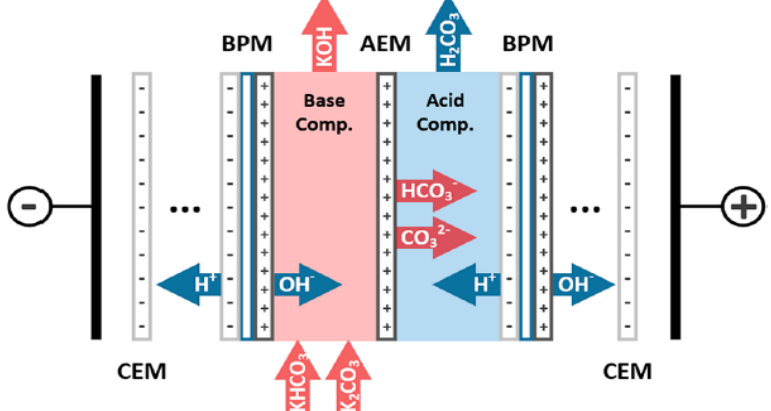
Figure 12. Configuration of BPMED cell (AEM = anion-exchange membrane, CEM = cation exchange membrane, BPM = bipolar membrane). Reproduced under the ACS AuthorChoice/Editors’ Choice via CC-BY-NC-ND Usage Agreement [22] .